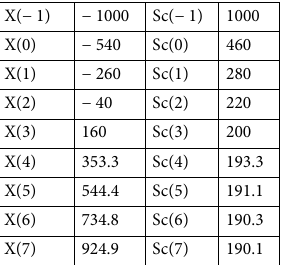
Table 1. Assembly dates ( X(n )) and corresponding duration of supercontinent cycles ( Sc ( n )) (in